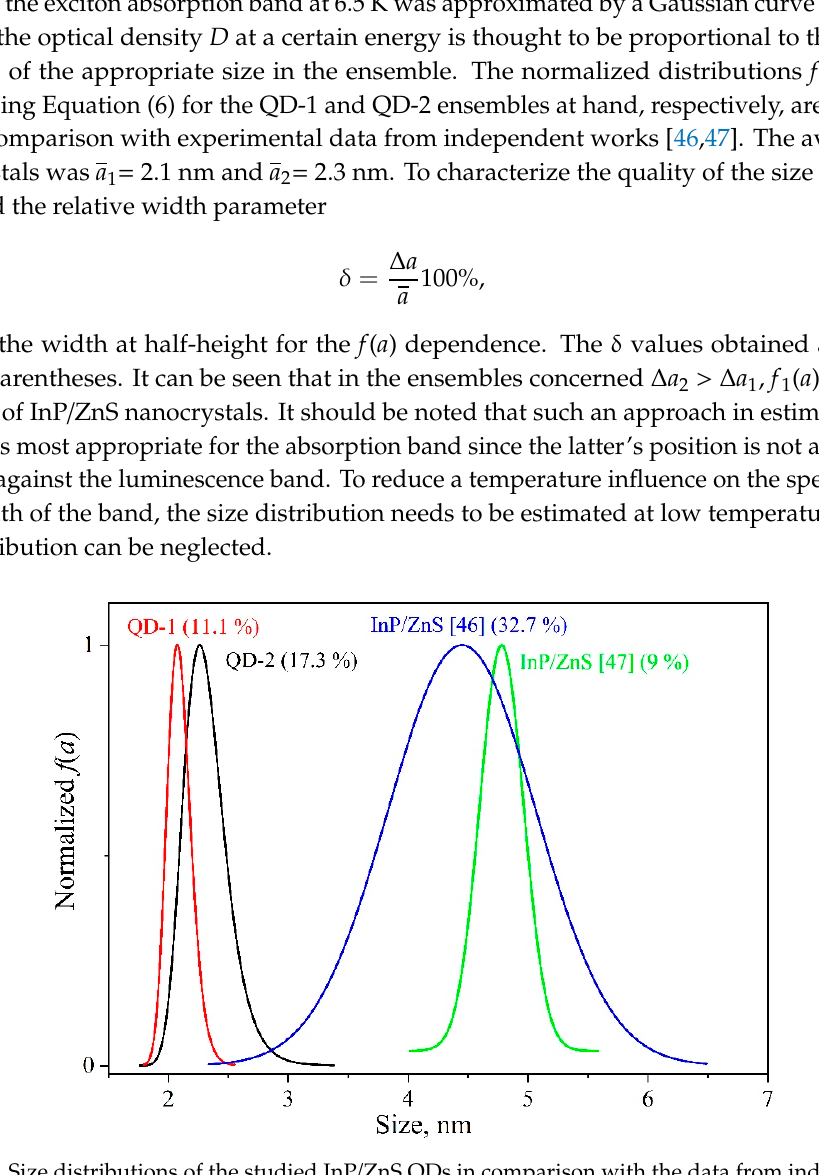
Figure 5. Size distributions of the studied InP / ZnS QDs in comparison with the data from independent works. The values of parameter δ calculated by the Equation (7) are given in parentheses.